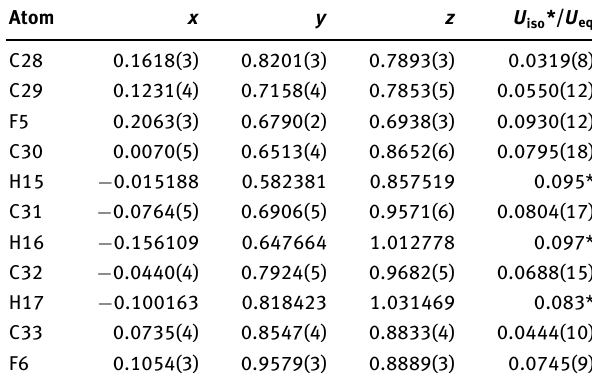
Table 2: Fractional atomic coordinates and isotropic or equivalent isotropic displacement parameters (Å 2